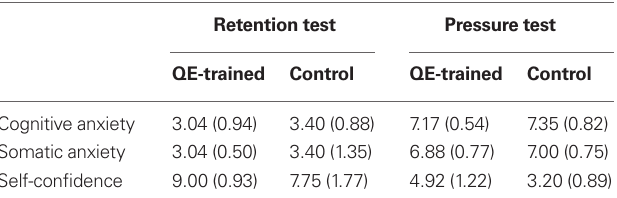
Table 1 | Mean (standard deviation) scores from MRF-3 questionnaire for QE-trained and Control groups across the test